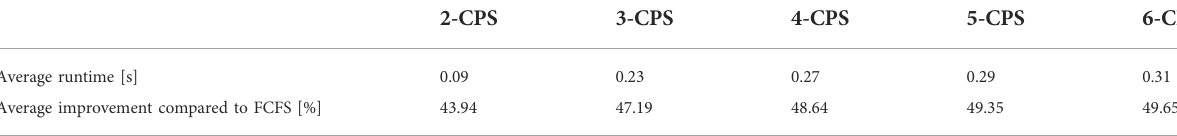
TABLE 7 Performance of the solver for Paris-Orly airport with N = 30 aircraft landing on one runway for different CPS-numbers.